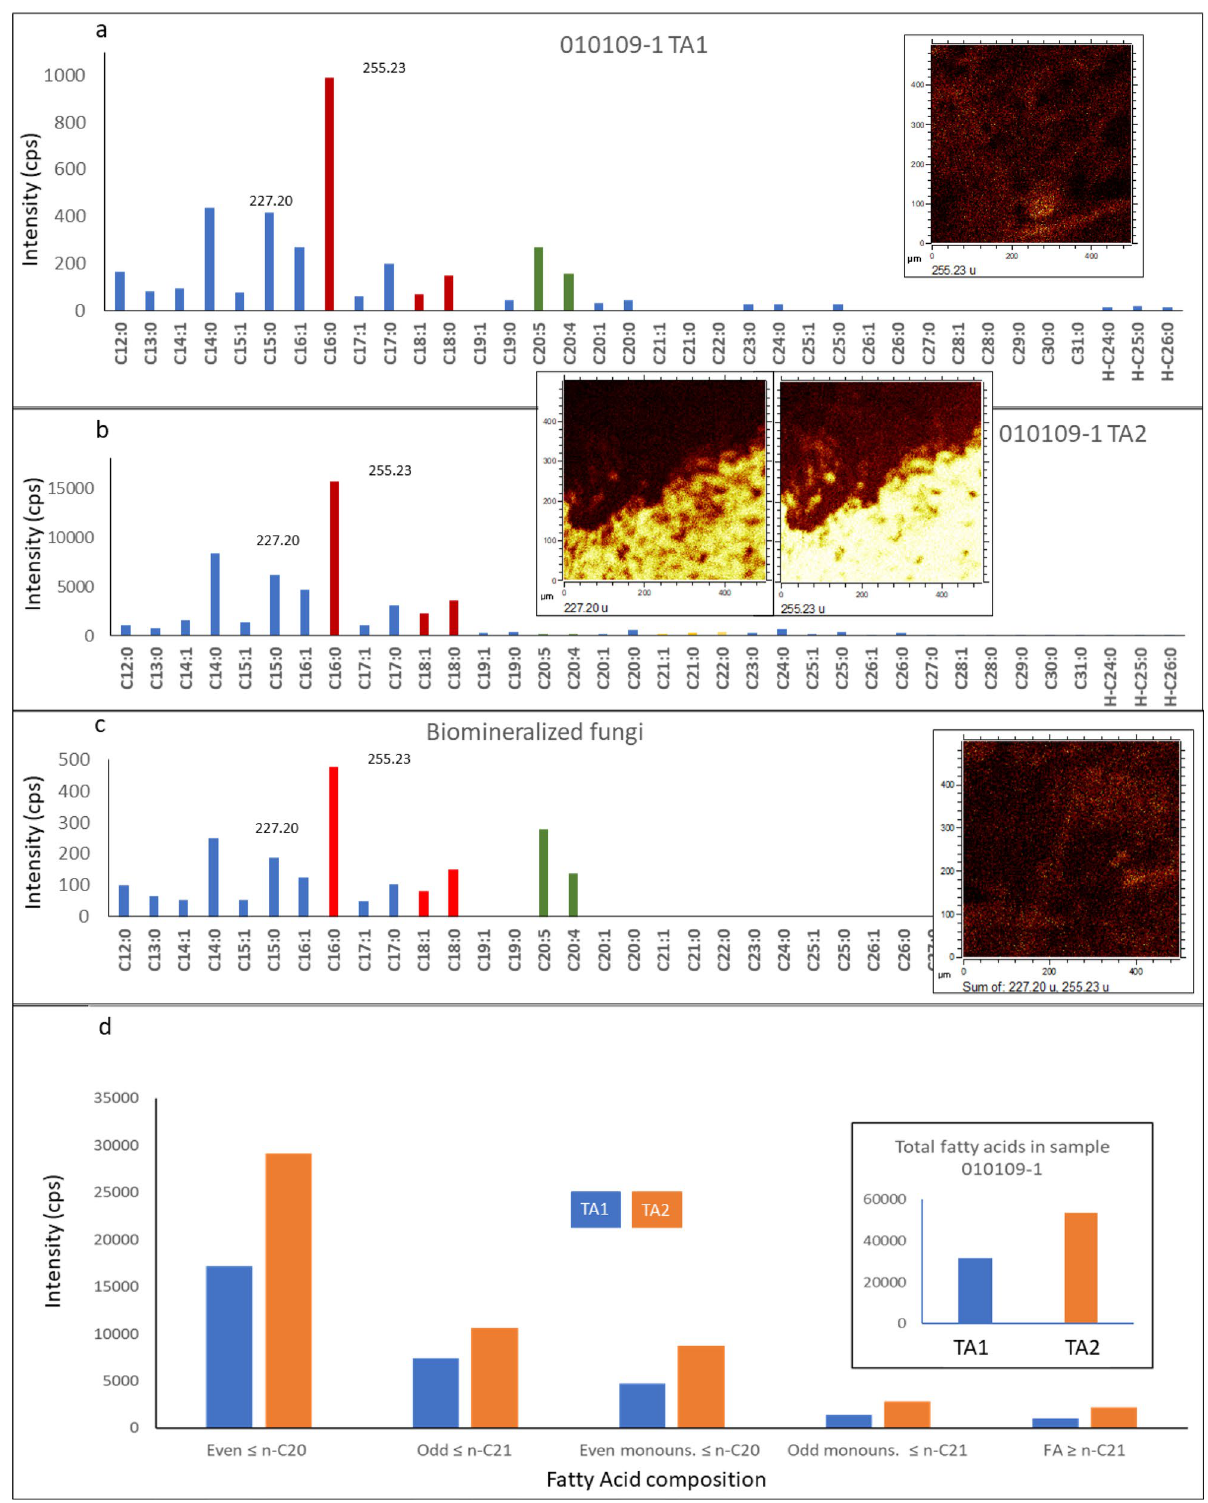
Figure 9. Occurrence and composition of fatty acids (FAs) through ToF–SIMS analysis in sample 010,109–1. The FA compositions found in TA1 ( a ) and TA2 ( b ) are very similar to the FA composition that was obtained in mineralized fungi ( c ) collected from microbial structures in Pyrenees mine galleries in which the biomass was dominated by fungal hyphae as reported by Fernandez-Remolar et al. (67). Interestingly, the highest FA intensity is found in TA2 rather than TA1 and the Pyrenean sample, which both show a similar intensity in FAs. Such a distribution strongly suggests different biological origins for TA2 versus TA1 and the mineralized fungi 66 . Indeed, PUFAs are shown as distinctive compounds in both TA1 and the Pyrenean sample. Furthermore, the account of the concentration of even versus odd FAs in TA1 and TA2 supports a microbial main source for